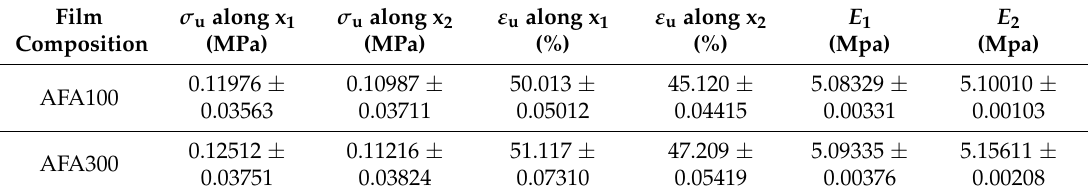
Table 2. Values obtained from Uniaxial tests on AFA100 and AFA300: Average ± SD.